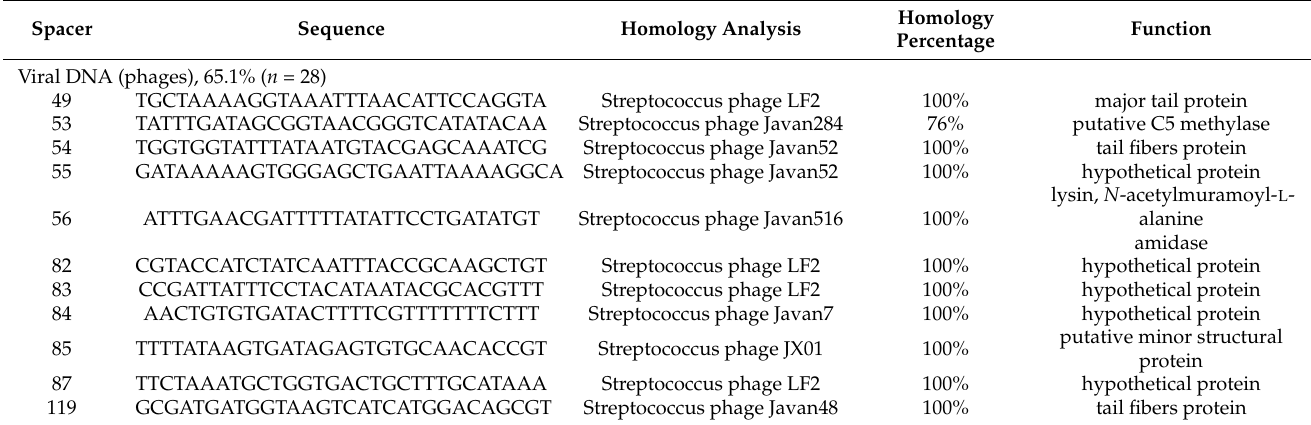
Homology Function Percentage